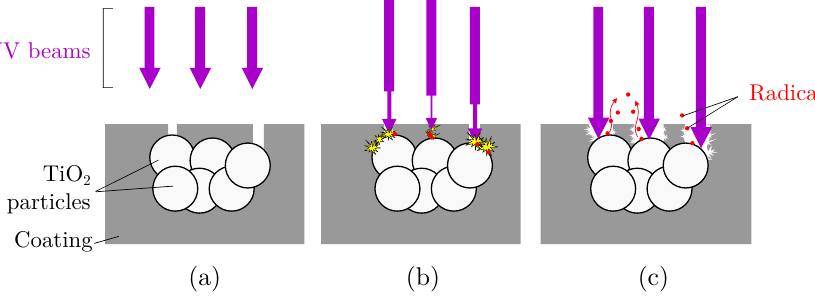
Figure 4. Schematic illustration of the disencapsulation mechanism of TiO 2 particles from acrylic coating. ( a ) starting UV pre-irradiation; ( b ) part of the UV beams reach particles near the surface, activating the photocatalytic reaction: the coating starts to degrade around particles; ( c ) apparition of additional porosity, favoring access of UV beams, diffusion of radicals outside the coating and diffusion of pollutants inside the